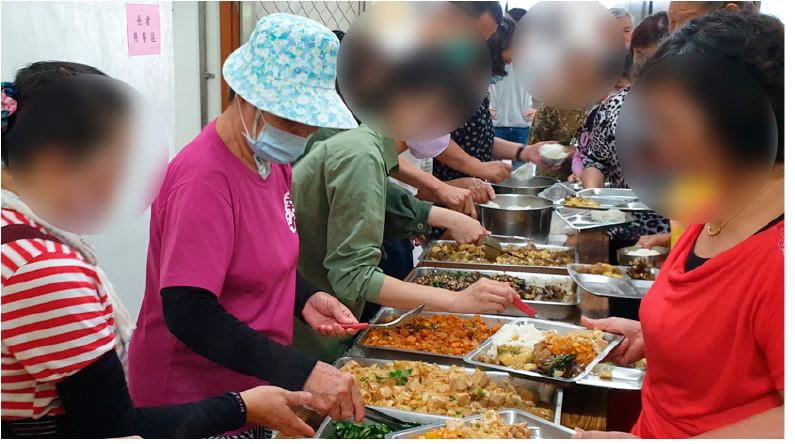
Figure 5. Older adults engage as volunteers for food service. (The image was taken by the